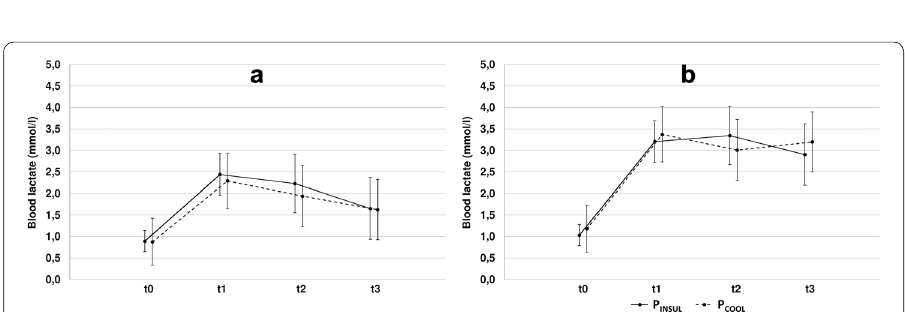
Fig. 5 Blood lactate levels as measured after warm-up (t0) and after 15 min (t1), 30 min (t2) and 45 min (t3) of running while wearing the thermally insulating (P INSUL ) and non-insulating (P COOL ) pants in studies A ( a ) and B ( b ). No significant differences were found between P INSUL and P COOL but factor time was significant in study A and B (p <